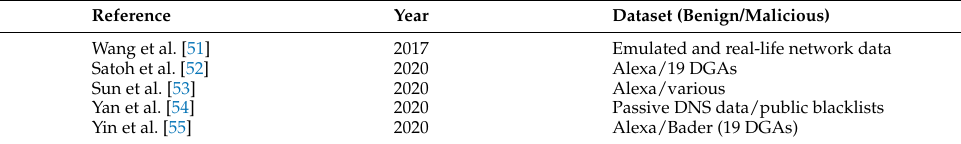
Table 3. DGA-based botnet detection using other